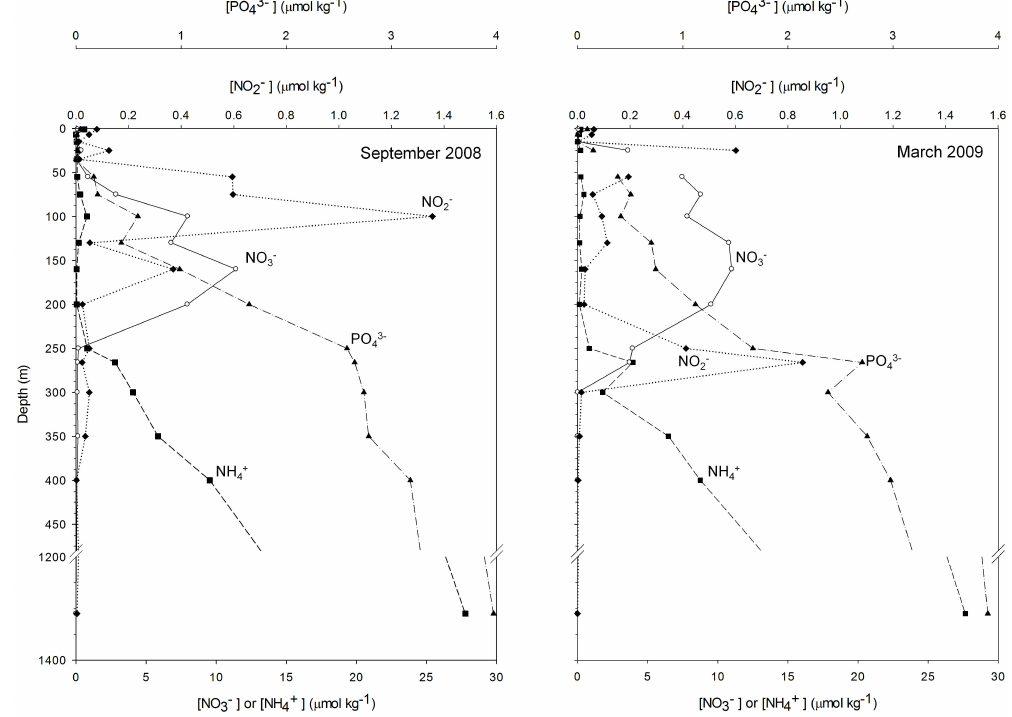
Fig. 4. Nutrient profiles from the CARIACO Time Series Station during September 2008 and March 2009.